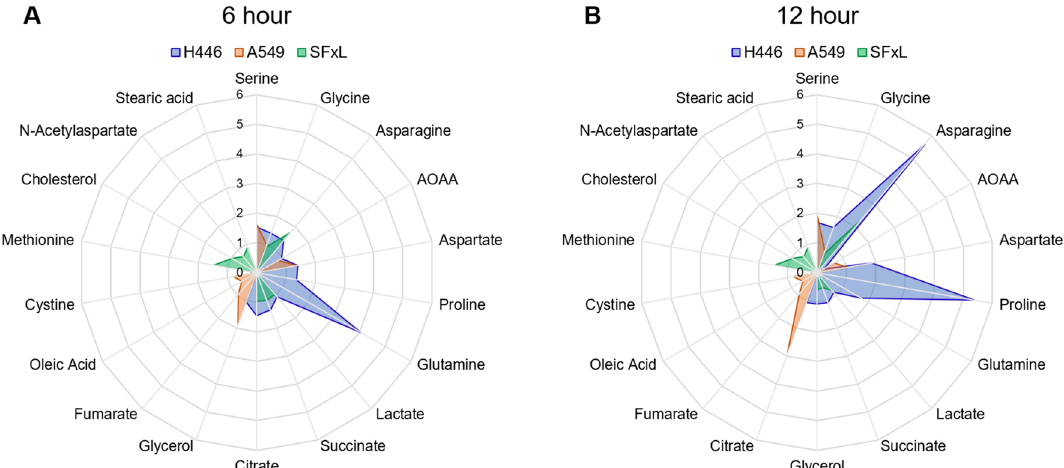
Figure 8. Metabolic profiles between 6 and 12 h post infection: Radar plots demonstrating the extent of changes observed in metabolite levels across 6 and 12 h of infection. The metabolites presented were selected based on the top 25 VIP scores and conservation across time points. The scale of the plots were kept the same to highlight the range of changes between the two time points for all three cells (H446, A549, SFxL). Note that H446 cells had the highest measured infectivity, as well as the greatest change in the metabolic profile versus control cells at both time